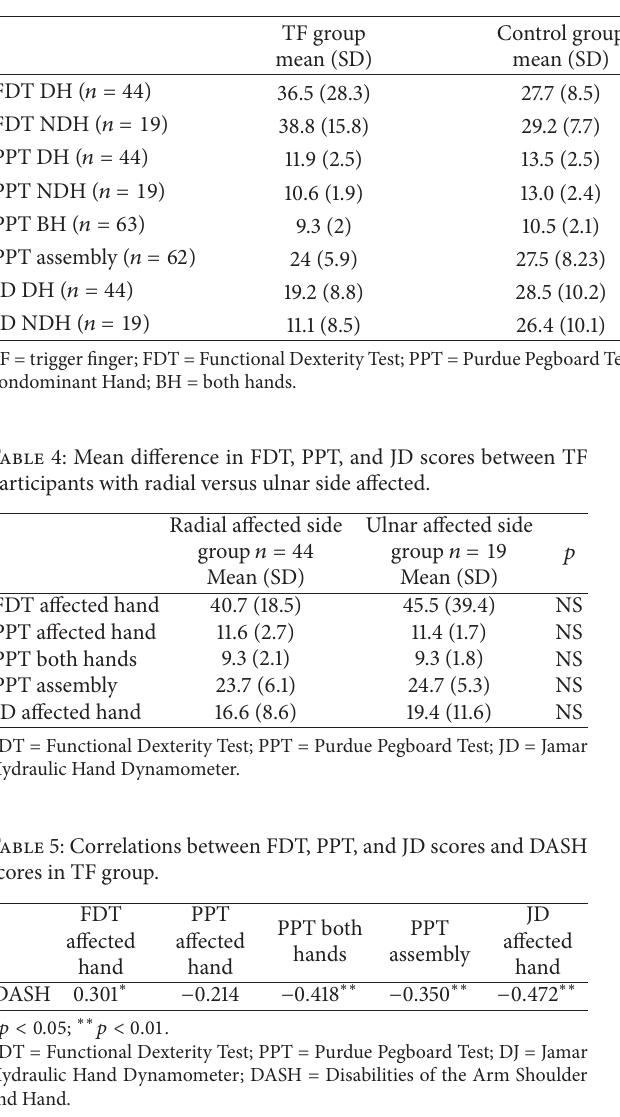
Table 3: Mean difference in in FDT, PPT, and JD among TF and control groups.